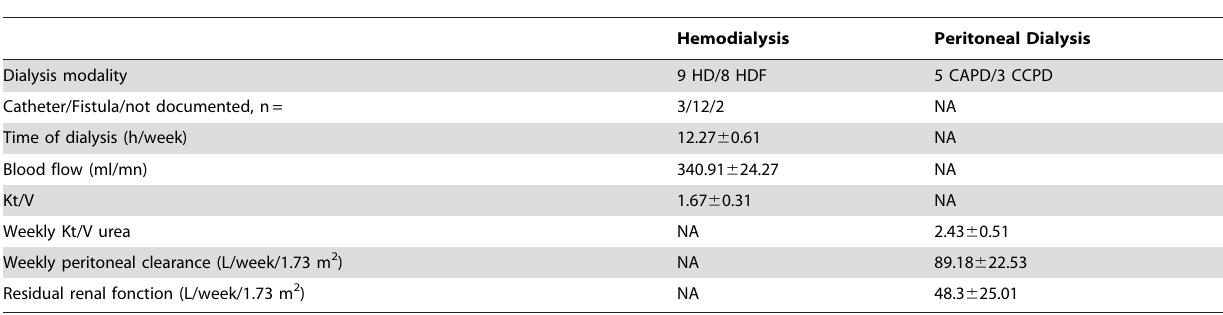
Table 2. Dialysis adequacy for HD and DP patients.